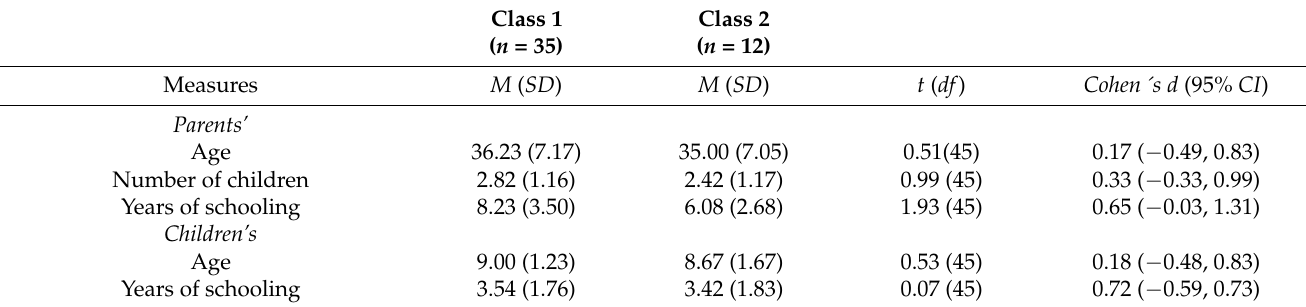
Table 7. Differences between classes on the continuous sociodemographic